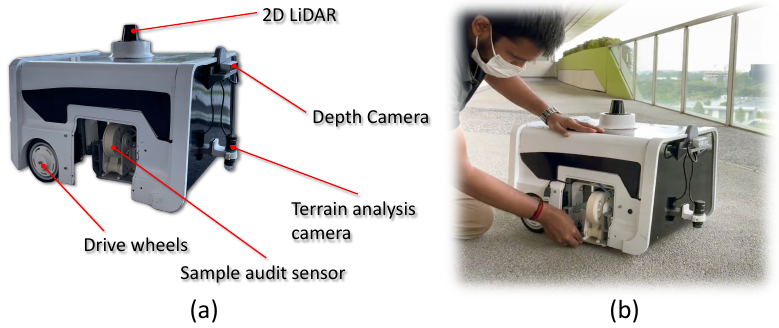
Figure 2. Cleaning audit robot—BELUGA ( a ); Attaching of sample audit sensor with BELUGA ( b ).